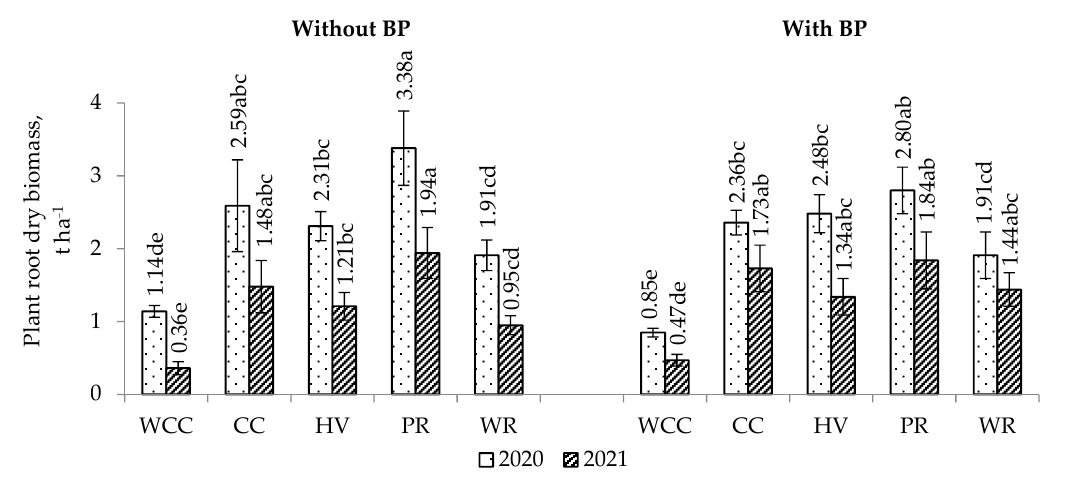
Figure 4. Plant root dry biomass. Note. BP—biopesticides (Factor A). Undersown cover crops (Factor B): WCC—without cover crop, CC—crimson (incarnate) clover, HV—hairy (winter) vetch, PR—perennial ryegrass, WR—winter rye. Differences between the averages of treatments marked with different letters (a, b, c, d, e) are significant ( p < 0.05); error bars indicate the standard error.